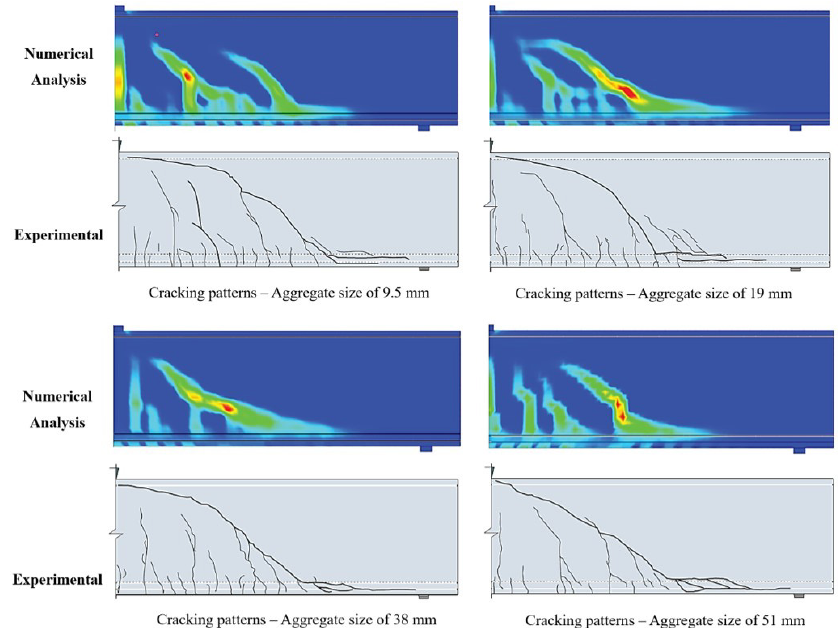
Figure 9. Numerical and experimental comparison for L-Series beams.